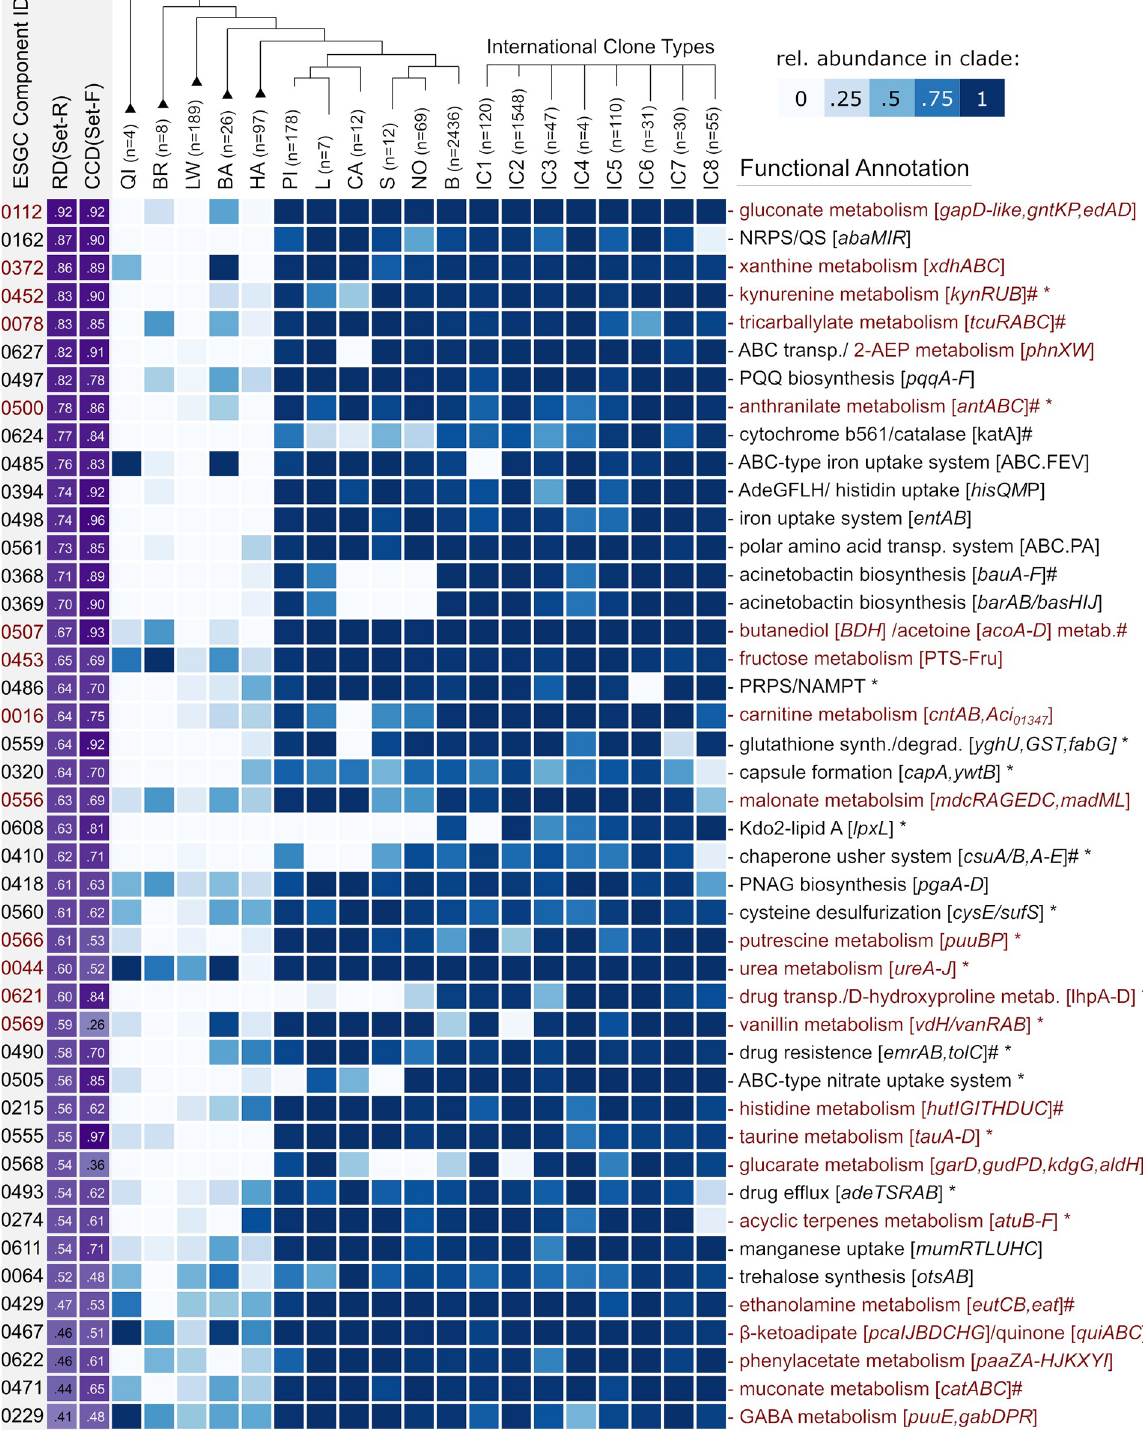
Fig 5. Phylogenetic profiles of 44 functionally annotated ESGC ACB across the Set-F. Shown are the selection of ESGC ACB with the highest abundance difference between the ACB clade and non-ACB taxa (RD). Ids refer to the corresponding connected components provided in S6 Table. Gene clusters are ranked by decreasing RD. The CCD (cluster conservation difference, violet) is calculated as the difference between the relative fractions of ACB-genomes minus non-ACB genomes where the cluster is present. The heat map informs about the fraction of taxa per clade harboring the ESGC ACB ranging from 0 (white) to 1 (dark blue). The total numbers of subsumed taxa per clade are given next to the